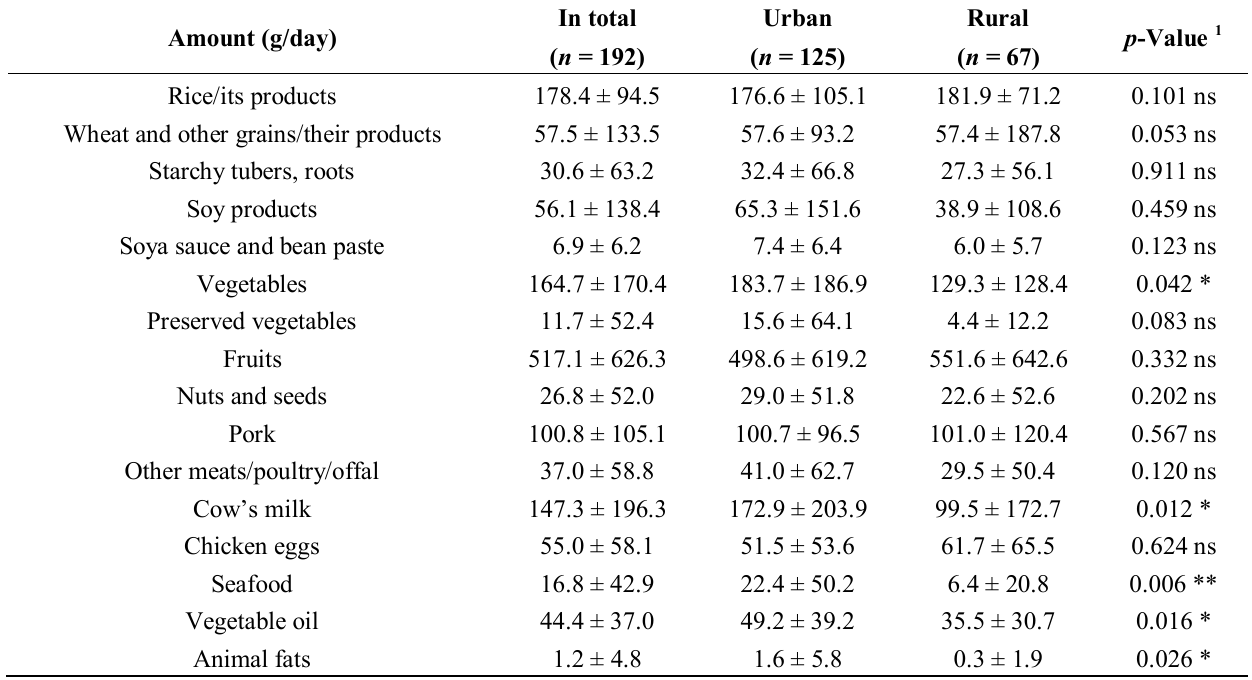
Table 4. Average food consumption of pregnant women living in urban and rural areas according to selected food